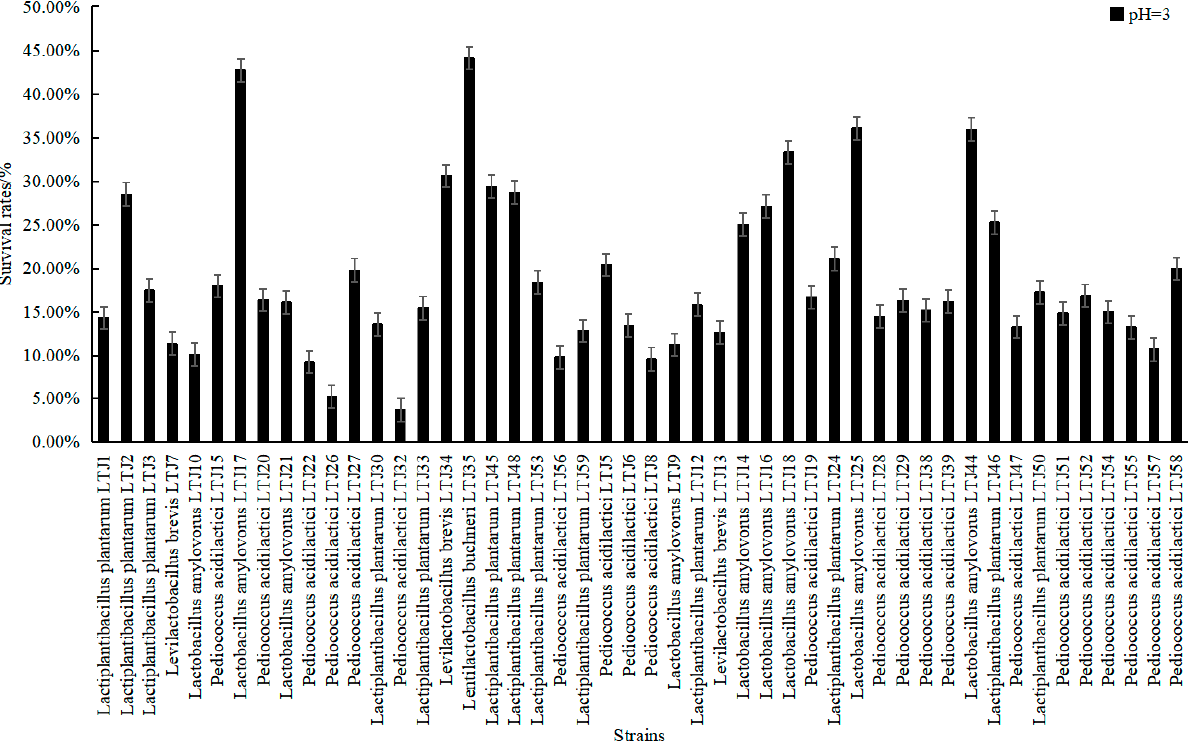
Figure 5. Determination of differences in acid resistance of strains.